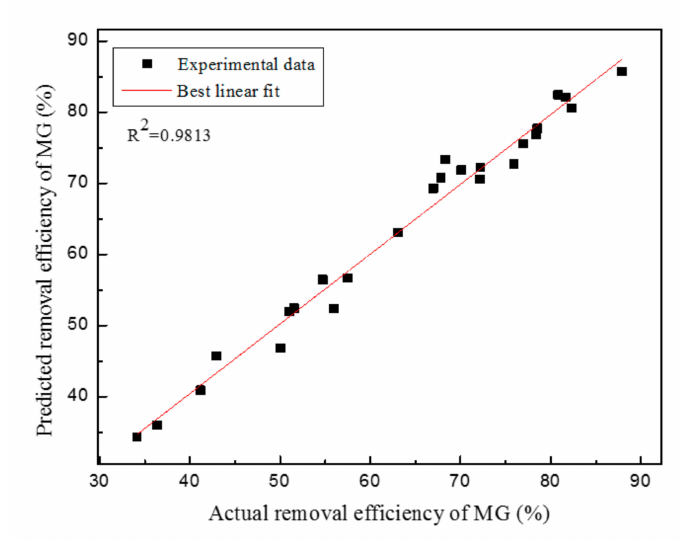
Figure 9. The plot of correlation between experimental and predicted removal efficiency.